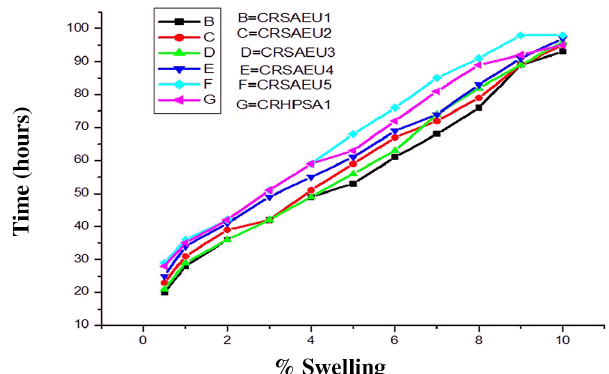
FIGURE 1 - Comparative % swelling studies of all formulations.